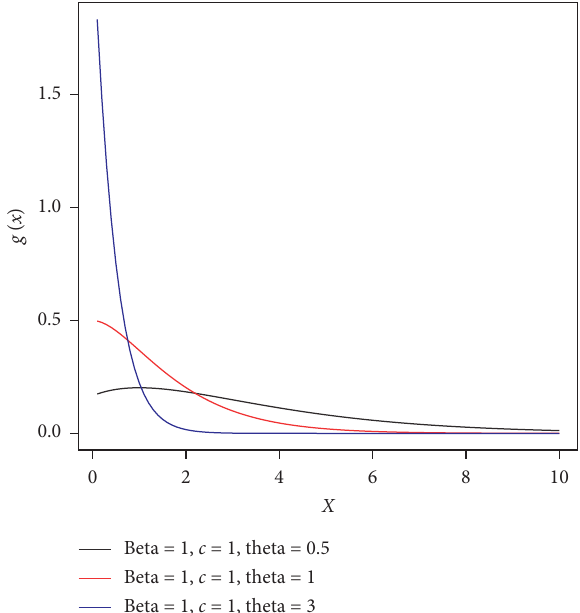
Figure 1: The pdf curves for generalized Weibull–Lindley (GWL) distribution for different parameter